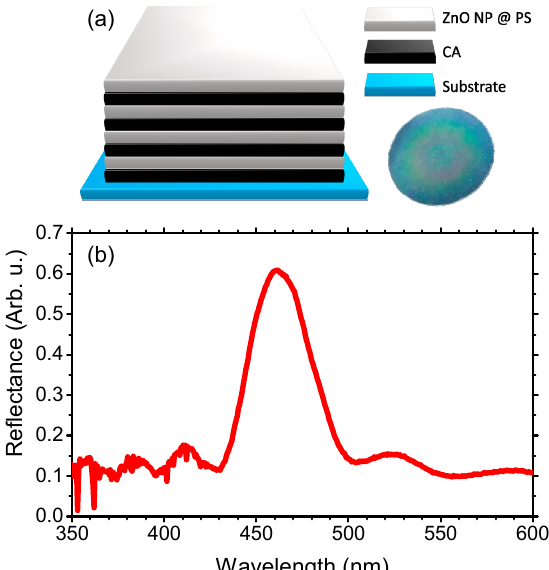
Figure 1. ( a ) Schematic and photograph of the ZnO nanoparticles (ZnONP)@PS/CA distributed Bragg reflector (DBR). ( b ) Reflectance spectrum of the sample.